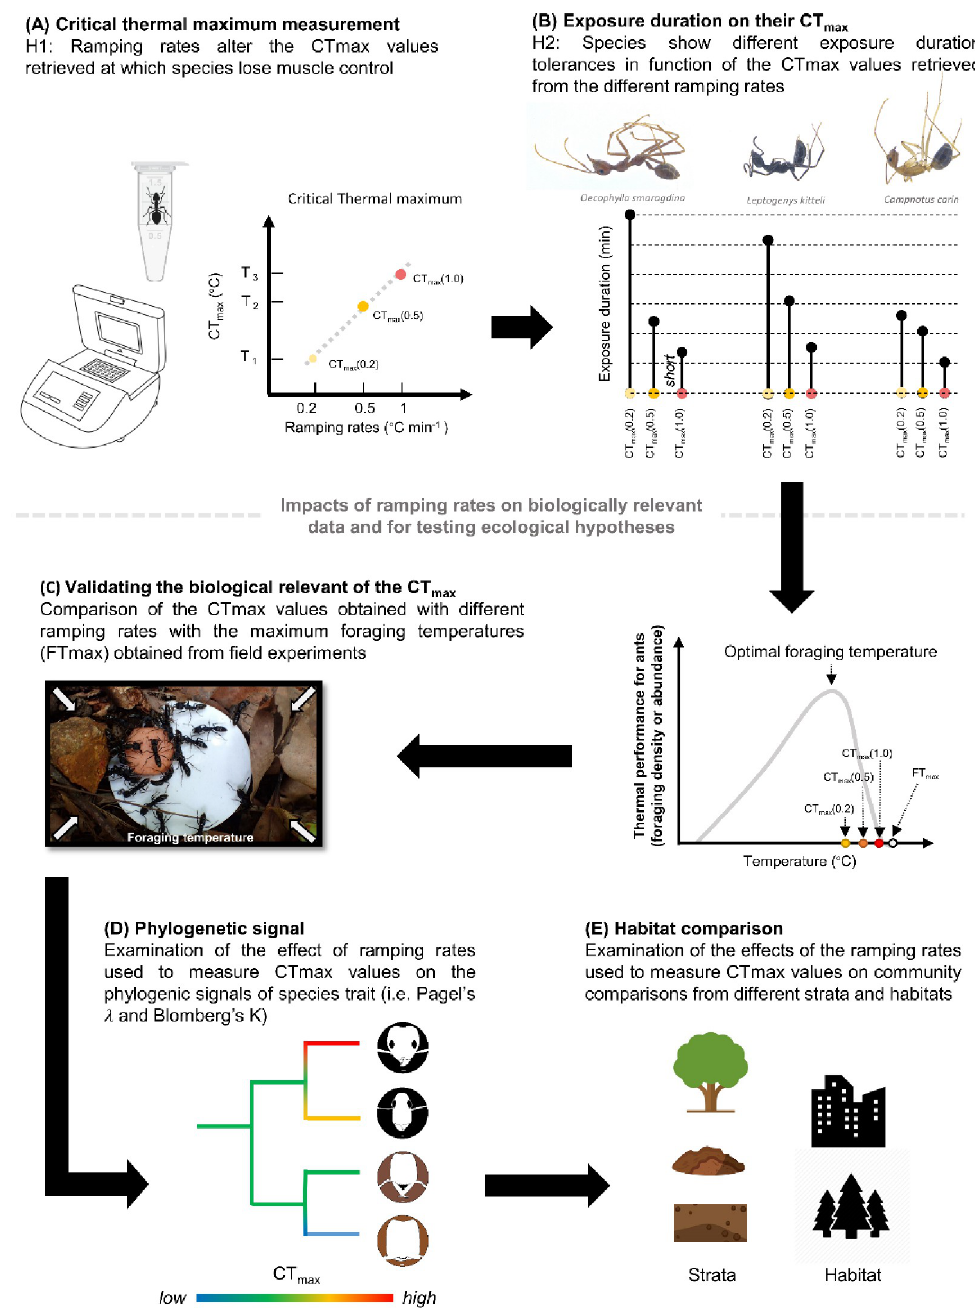
Fig 1. Study diagram of testing implications of ramping rates in the measurement of Critical Thermal maximum. (A) The first hypothesis (H1) examines if a positive relationship between the ramping rates and CT max values exists for each ant species at the intraspecific level. (B) The second hypothesis (H2) examines the interspecific variations of exposure duration-based tolerance in function of the temperature treatments, we hypothesize that species assemblages show different exposure durations in their CT max (0.2) values but presenting consistence in their CT max (0.5) and CT max (1) values. (C) Thermal performance framework of ectotherm on the basis of foraging behavior illustrate species activity in function of the temperature increase, FT max recorded in the field presents critical and act as a thermal threshold for the organisms; the thermal performance curve is predicted based on the ant foraging activity in function of temperature. Through the comparison between CT max and FT max , the results can examine will the species stop at their CT max if the environmental temperature reached their CT max and provide a biologically relevant ranking of the CT max values retrieved by different ramping rates (0.2, 0.5 and 1˚Cmin -1 ). (D) Examination of the effect of ramping rates used to measure CT max values on